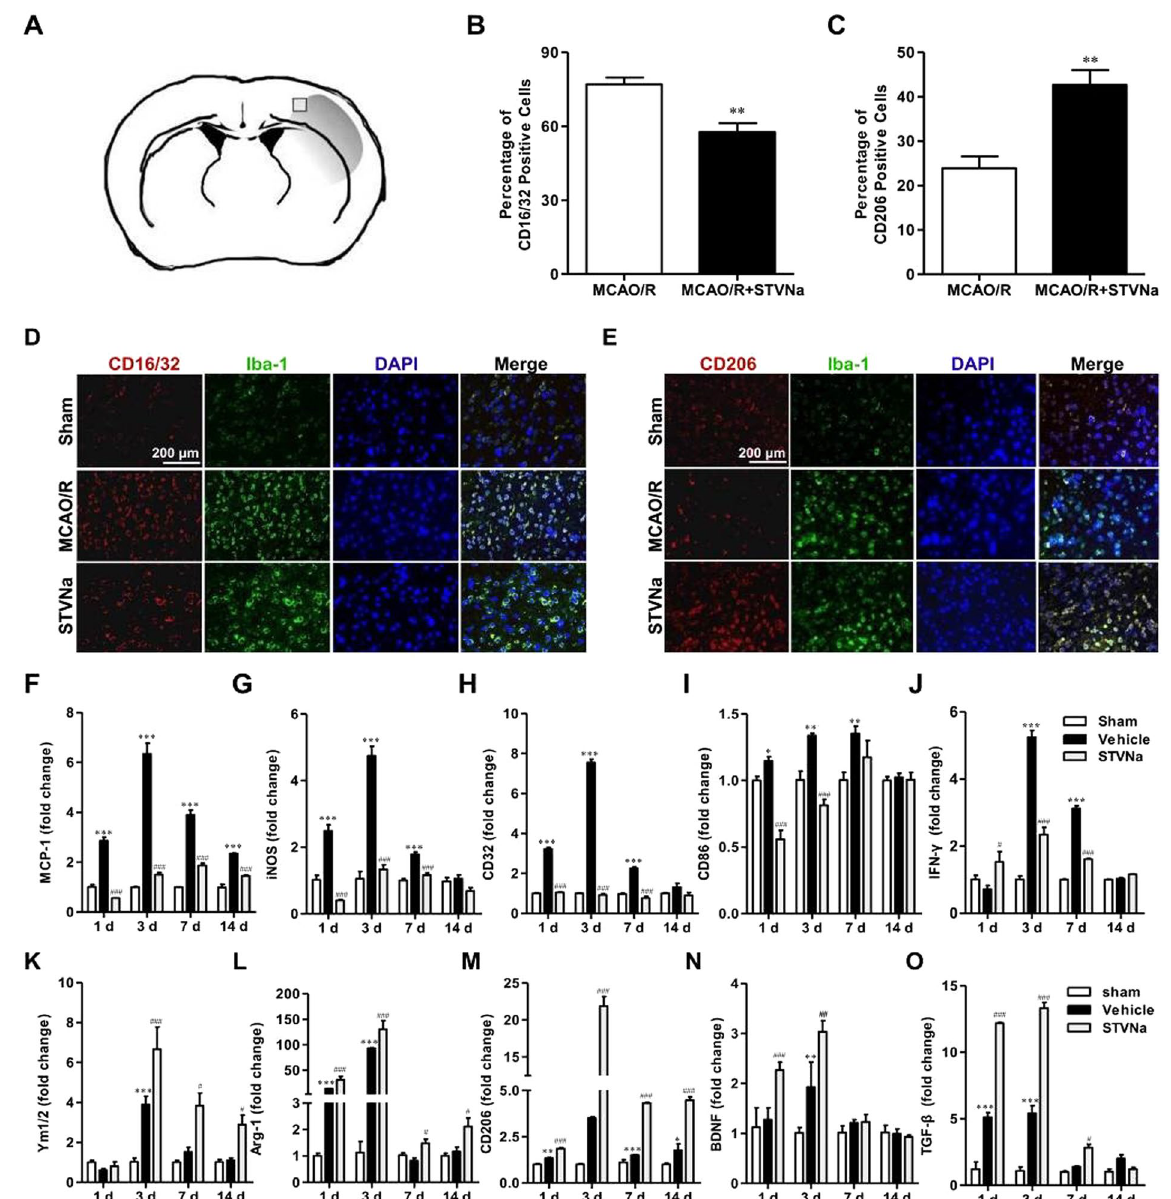
Figure 2. STV-Na treatment enhances M2 polarization and suppresses M1 polarization of microglia in the ischemic cortex after MCAO/R. Representative double-immunofluorescence staining for CD16/32 or CD206 and Iba-1 markers in brain sections obtained from STV-Na or vehicle-treated mice 3 days after MCAO/R, or from sham-operated mice. Scale bar: 200 μ m. ( A ) Sketch picture showing the position of the immunofluorescence pictures obtained from the peri-infarct of cortex. ( B ) Quantification of the percentage of CD16/32 + /Iba-1 + cells among total Iba-1 + cells. ( C ) Quantification of the percentage of CD206 + /Iba-1 + cell among total Iba-1 + cells. ( D ) Cortex sections co-stained for CD16/32 (M1 marker) (red) and Iba-1(green). ( E ) Cortex sections co-stained for CD206 (M2 marker) (red) and Iba-1 (green). ( F – O ) RT-PCR analysis of M1 (MCP-1, iNOS, CD32, CD86, IFN- γ ) and M2 (Ym1/2, Arg-1, CD206, BDNF, TGF- β ) markers in the ischemic cortex at 1, 3, 7, 14 days after MCAO/R. Data are represented as mean ± SD, * P < 0.05, ** P < 0.01, *** P < 0.01, versus Sham; # P < 0.05, ## P < 0.01, ### P < 0.001, versus Vehicle